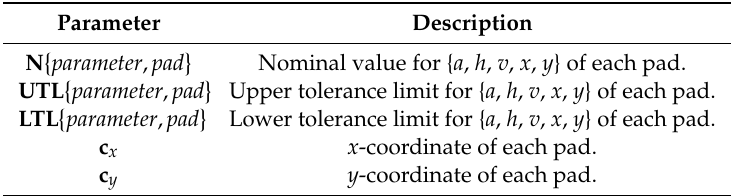
Table 1. Tolerance specifications of the PCB (inputs to the AGV module).